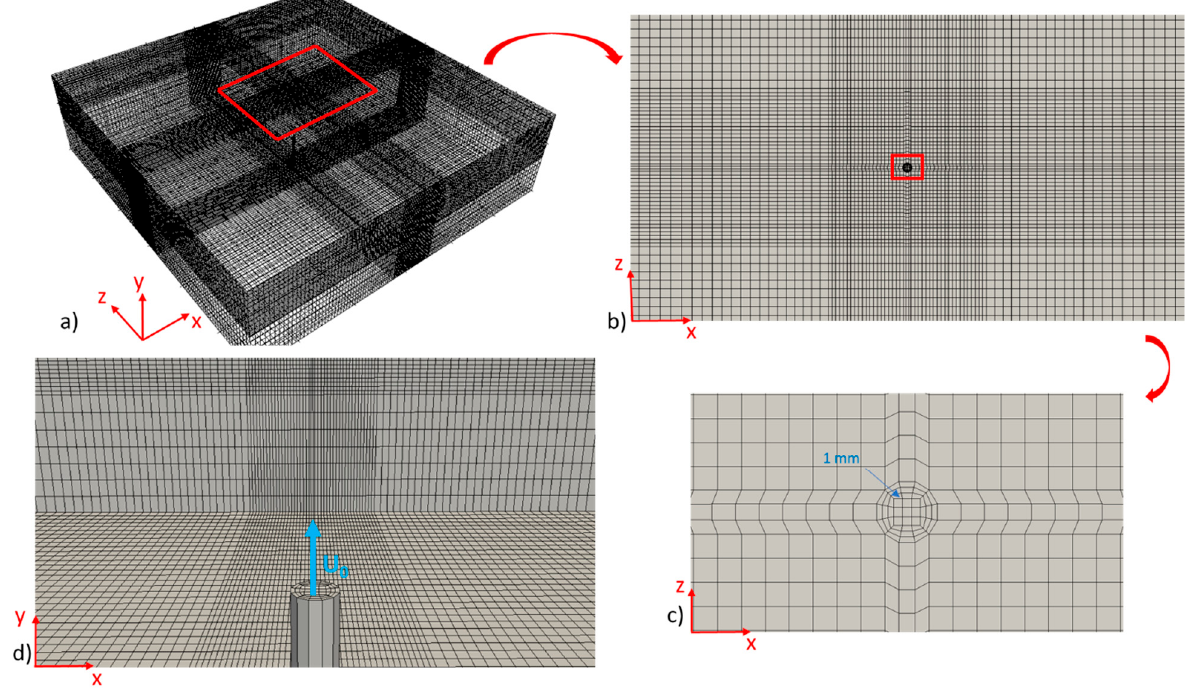
Figure 3. Model geometry and computational mesh: ( a ) full mesh, ( b ) x-z plain, ( c ) zoomed-in top face of the nozzle, and ( d ) x-y view of the nozzle.